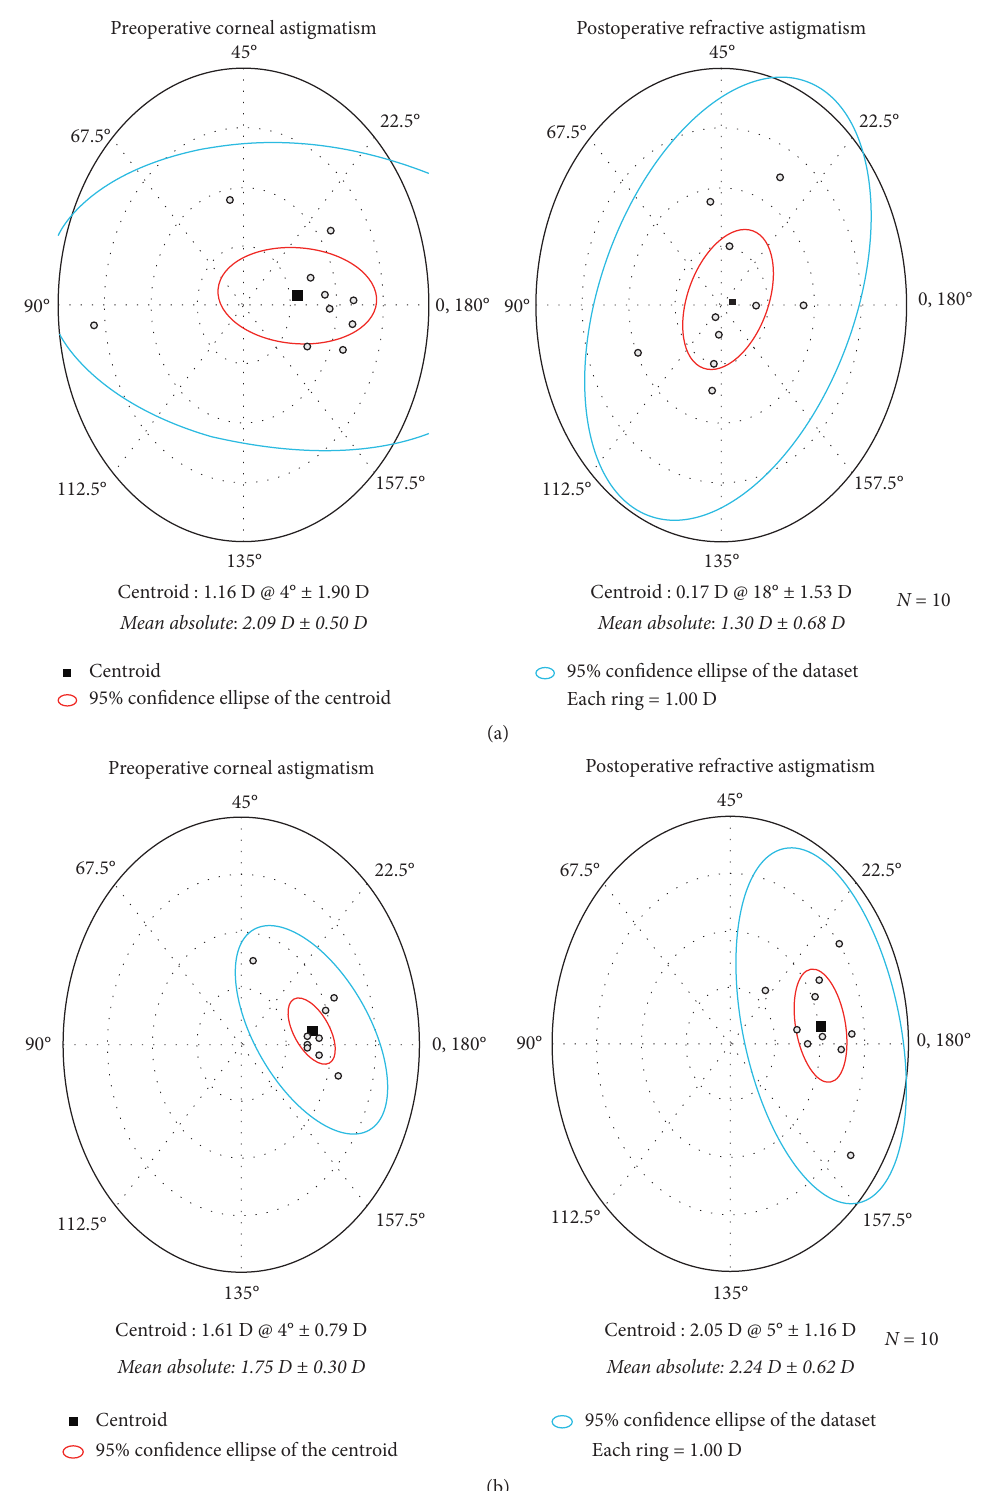
Figure 2: The double-angle plots show the preoperative and postoperative astigmatic vectors and their means and spread in the toric IOL (a) and nontoric IOL groups (b). The black squares indicate the centroids, the red circles indicate the 95% confidence ellipses of the centroids, and the blue circles indicate the 95% confidence ellipses of the